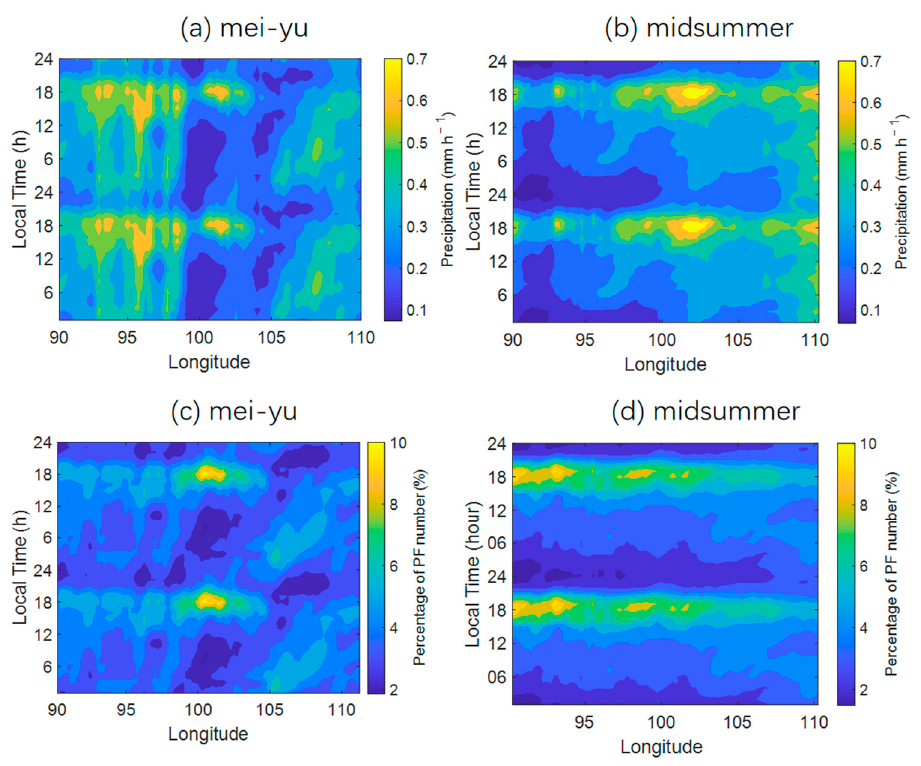
Figure 2. The ( a , b ) diurnal variation in precipitation and ( c , d ) precipitation feature number percentage during the ( a , c ) mei-yu and ( b , d ) midsummer period from the Hydro Estimator satellite rainfall estimates.